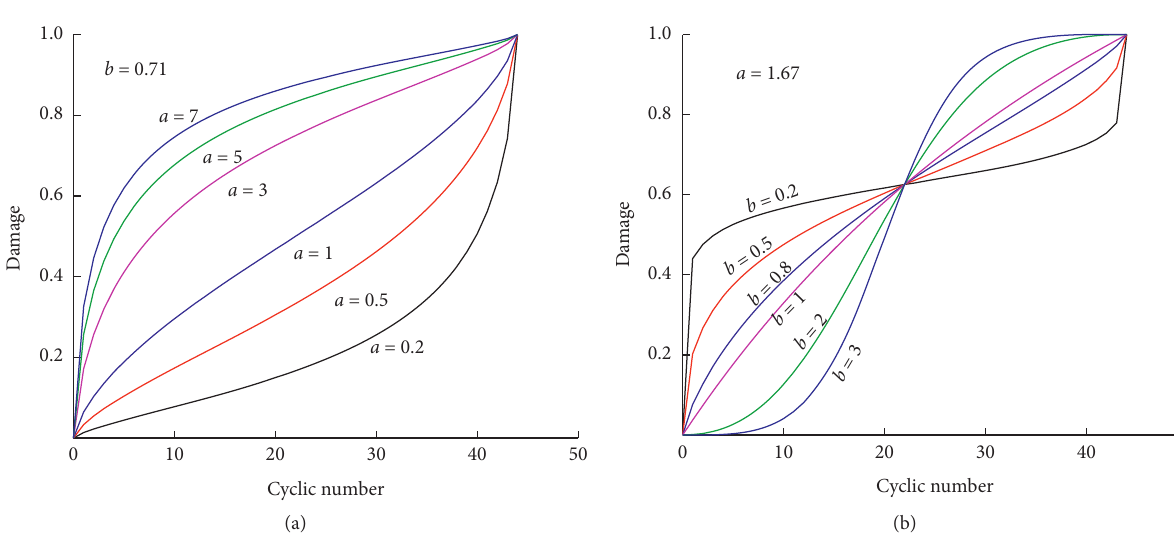
Figure 11: Impact of model inflection point for the rock salt indicates the minimum value Table 3. It can be found that the model parameter a and b increase with the increase of D , and the fitting value of the Nf/ 2 parameter a is closer to the corresponding result of D 4.5. However, the fitting value of b is closer to the result of D for the 5 salt rock, while being D for the granite. Residual strain growth 4.5 coefficient, the calculated values are highly consistent with the rate (single plastic strain increment) in Figure 12 also indicates experimental values when the average values of adjacent points that the process from the fourth to the fifth cycle is the inflection are taken to calculate the model parameters. point of the two kinds of rocks, while the difference is that the